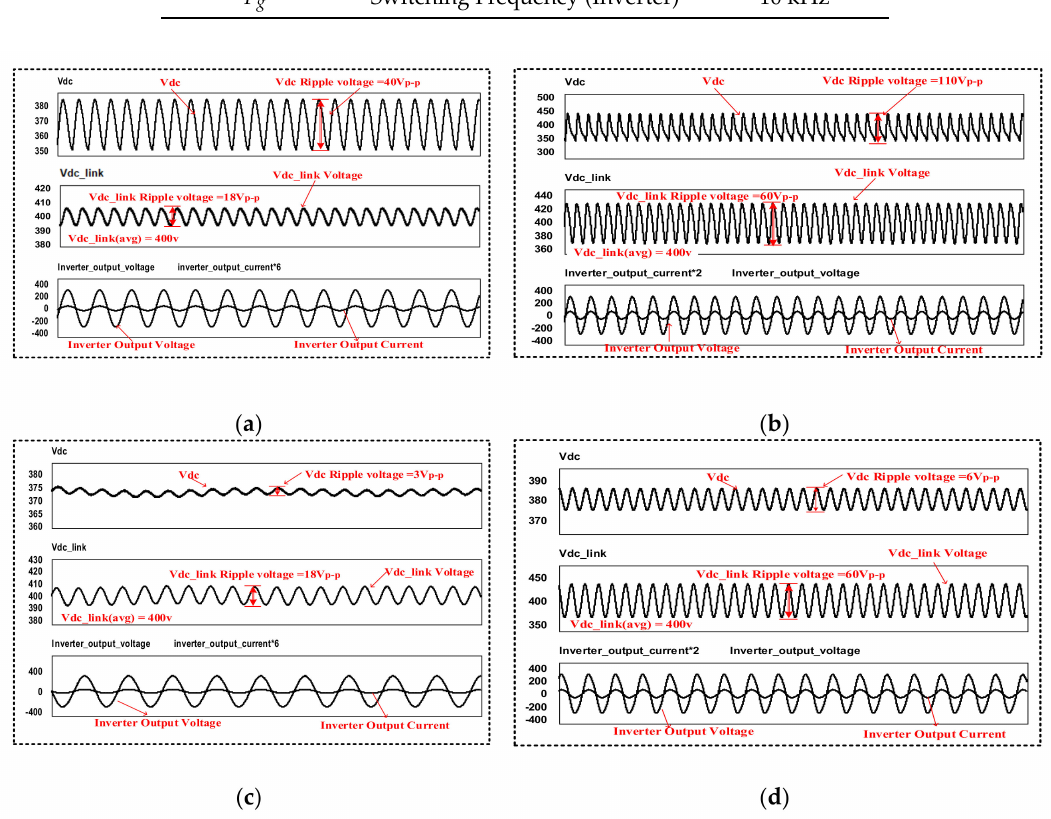
Figure 10. Simulation results: ( a ) without the proposed control method at 1 kW; ( b ) without the proposed control method at 5 kW; ( c ) with the proposed control method at 1 kW; ( d ) with the proposed control method at 5